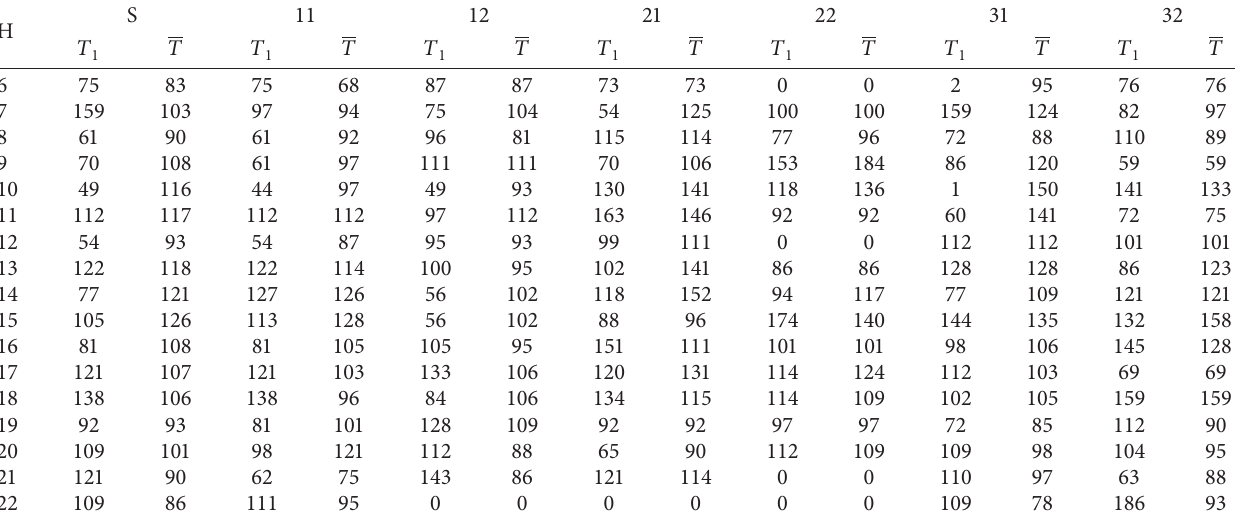
Table 2: Head vehicle travel time and average travel time on December 2, 2015.